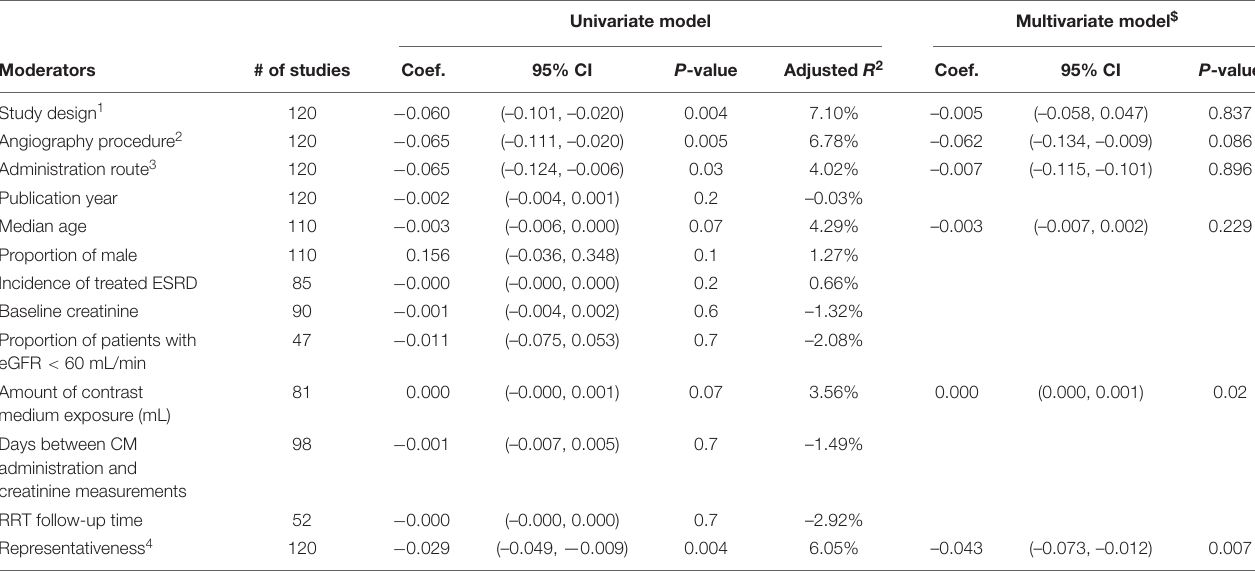
TABLE 2 | Univariable and multivariable meta-regression analyses of potential source of heterogeneity for incidence proportion of contrast-induced